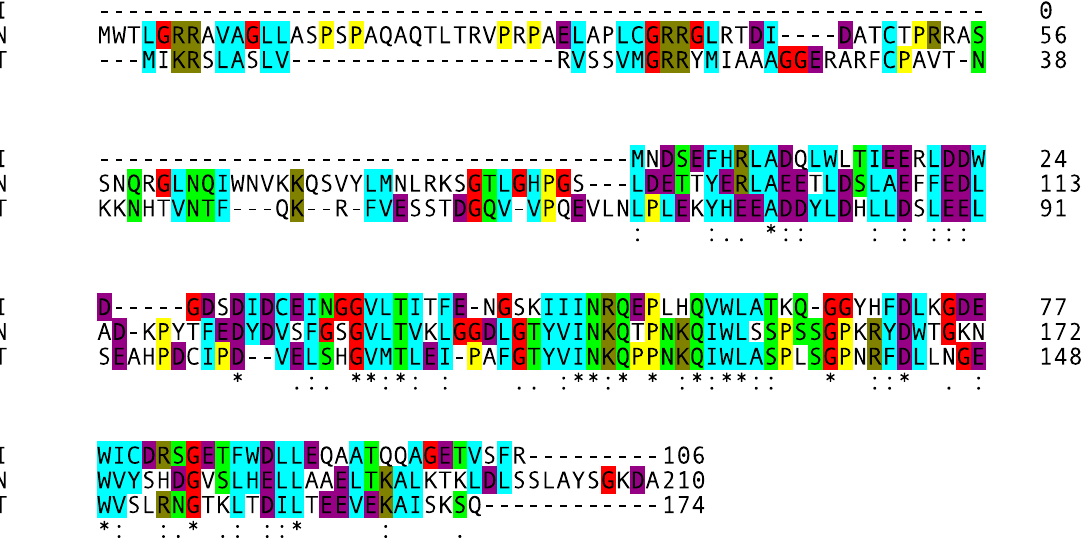
Figure 3. Multiple alignment of the three frataxin orthologues obtained with Clustal Omega and color-coded to emphasize the conserved sequence.